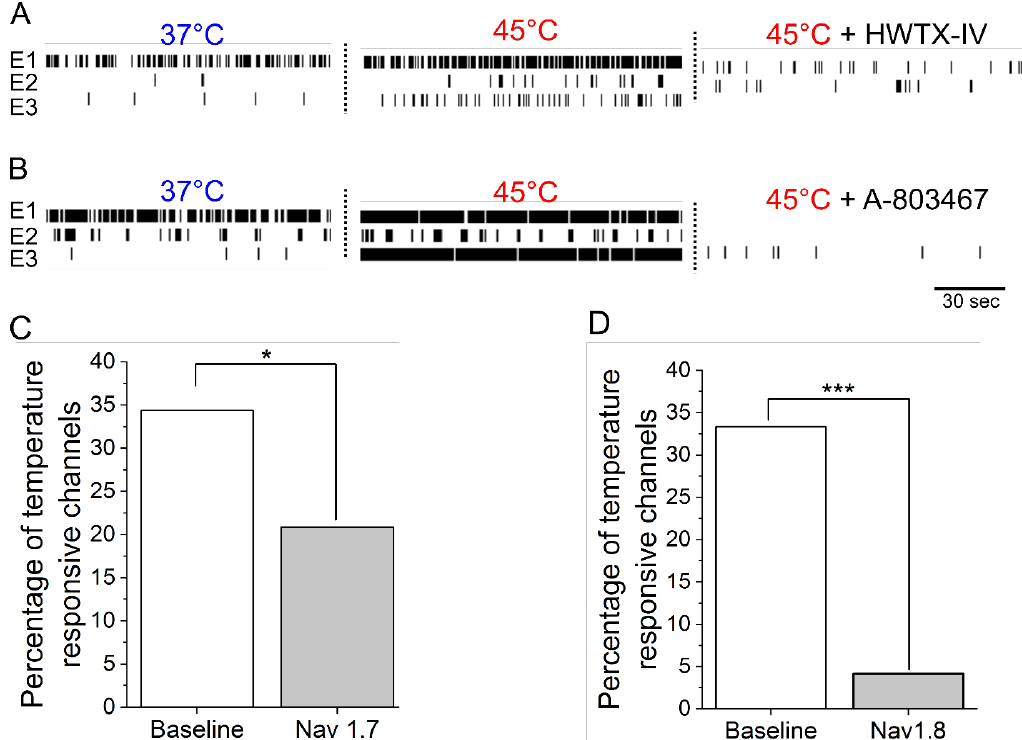
Figure 3. Potent and selective antagonists of Nav1.7 and Nav1.8 inhibit thermally evoked responses in sensitized adult DRG cultures. ( A ) Raster plots of three representative electrodes at 37 ◦ C (left), 45 ◦ C (middle), and after the addition of 30 nM HWTX-IV. ( B ) Raster plots of three representative electrodes at 37 ◦ C, 45 ◦ C, and after the addition of 300 nM A-803467. Summarized percentage of temperature responsive electrodes at baseline and after the addition of ( C ) Nav1.7 blocker (30 nM HWTX-IV) and ( D ) Nav1.8 blocker (300 nM A-803467). 3.3. Nav1.7/1.8 Expression is Unchanged after 72 Hour IL-6 and NGF Treatment